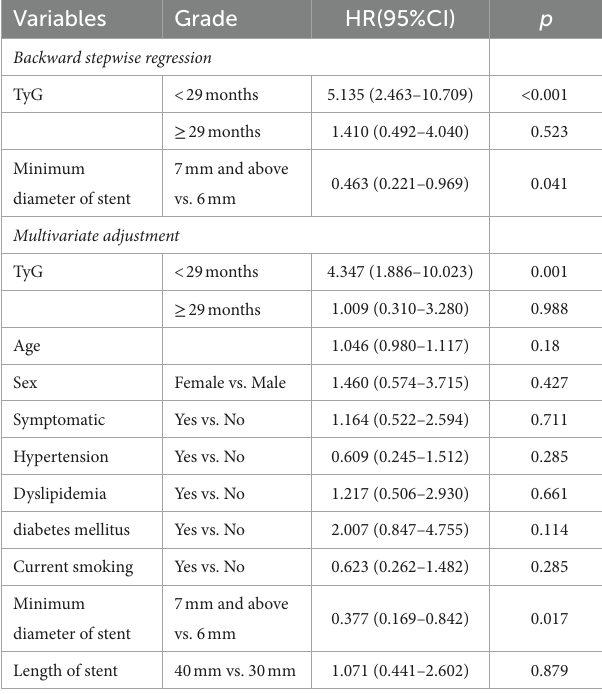
TABLE 2 Univariate Cox regression. TABLE 3 Multivariate Cox